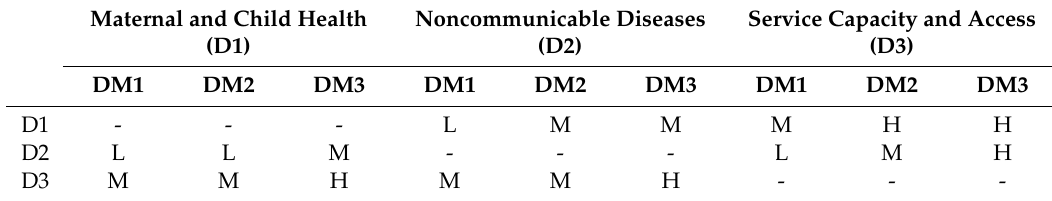
Table 3. Linguistic evaluations of decision makers for the service-based perspective.